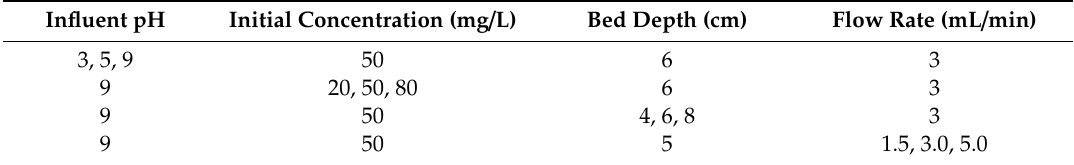
Table 2. Column experimental conditions during the binary adsorption of MG and MB dye onto T-PAA. Influent pH Initial Concentration (mg / L) Bed Depth (cm) Flow Rate (mL / min) 3, 5, 9 50 6 3 9 20, 50, 80 6 3 9 50 4, 6, 8 3 9 50 5 1.5, 3.0,